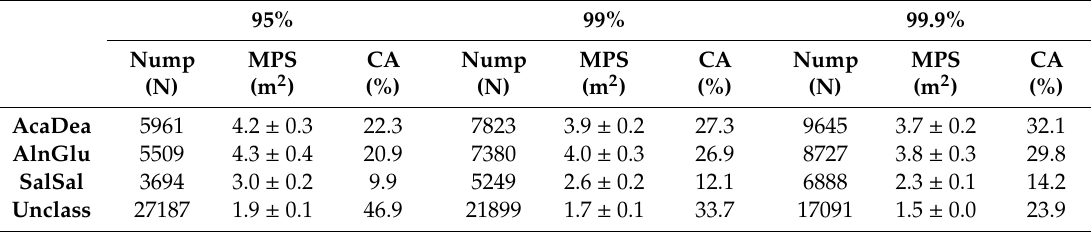
Table 3. Number of objects (Nump), mean patch size (MPS) ± standard error and percentage of class area (CA) of the classified riparian objects in the three dominant species ( Acacia dealbata , Alnus glutinosa and Salix salviifolia ) and the unclassified riparian objects (Unclass) relative to the total study area, using the three regions of classification probability (95%, 99% and 99.9%).